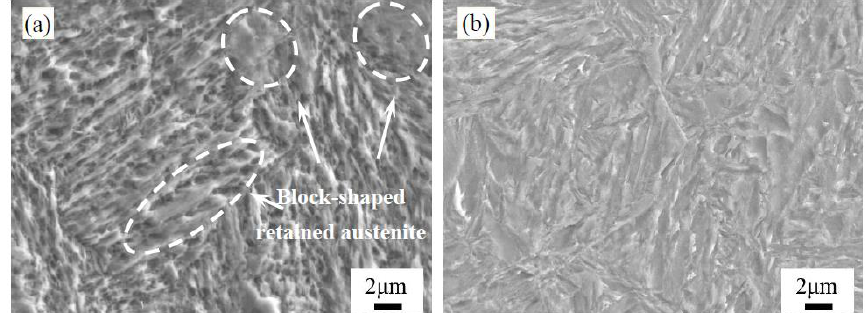
Figure 8. SEM images of the morphology of the carburized layer at a 0.3 mm depth for process 1: ( a ) after quenching; and ( b ) after the low-temperature tempering.